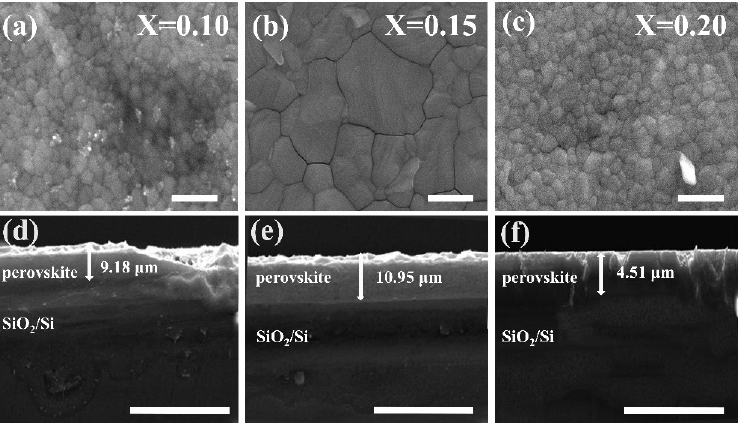
Figure 2. ( a – c ) SEM images of FA 1 − x Cs x PbI 3 thin films with varying compositions ( x = 0.10, 0.15, and 0.20, respectively), scale bar, 2 µm. ( d – f ) show the corresponding ( x = 0.10, 0.15, and 0.20, respectively) cross-section SEM image of the FA 1 − x Cs x PbI 3 thin films; the thickness is 9.18 µ m, 10.95 µ m, 4.51 µ m, respectively, scale bar, 100 µ